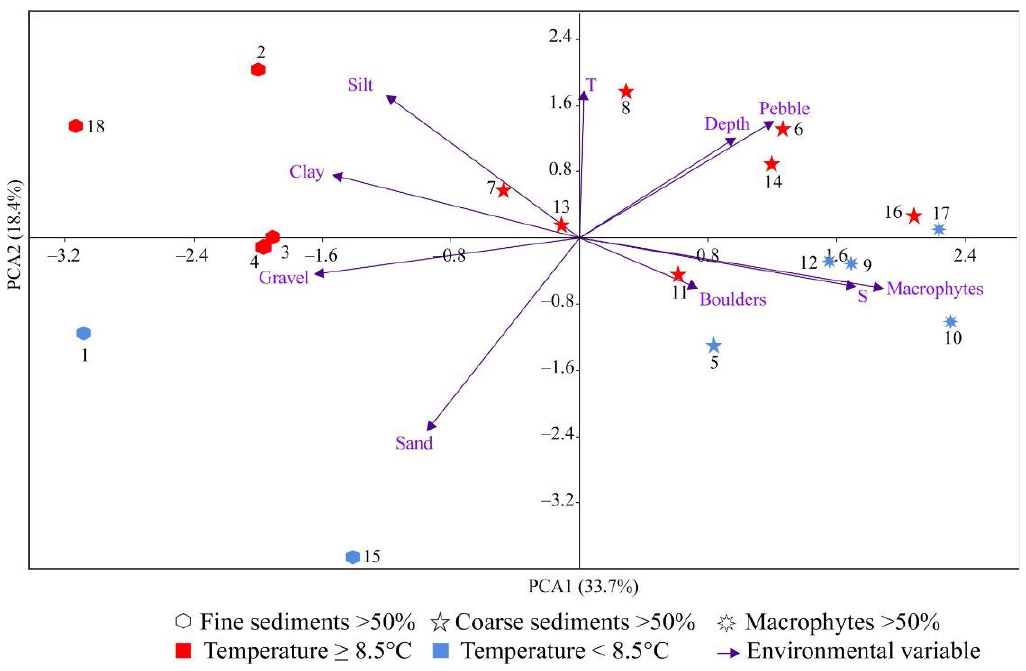
Figure 3. Biplot of principal component analysis of environmental variables at sampling stations located in Grønfjorden. T — temperature (°C), S — salinity, Depth — depth (m), Clay, Silt, Sand, Gravel, Pebbles, Boulders, Macrophytes — proportions of corresponding substrates (%).